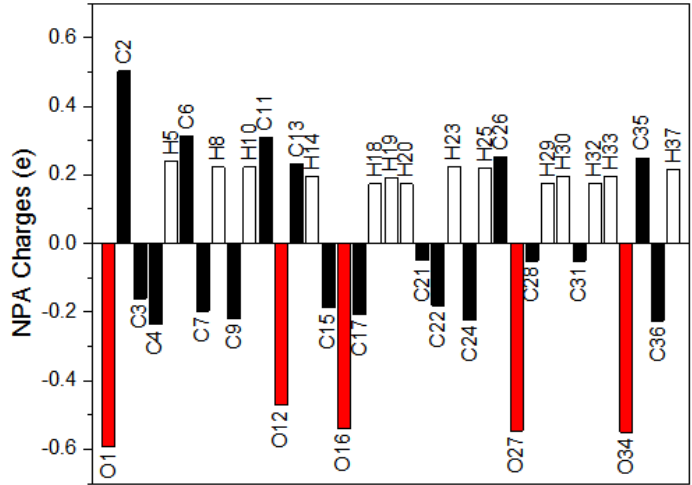
Figure 9. Atomic charge distribution of compound 6. The numbering of atoms in Figure 9 follows Supplementary Figure S6.